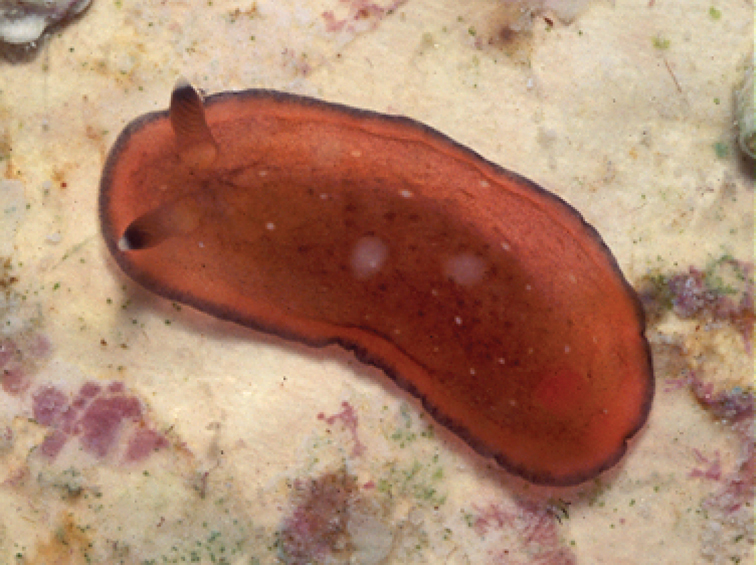
Dendrodoris nigra, red juvenile, Maldives, photo: J Hinterkircher (no spcm).